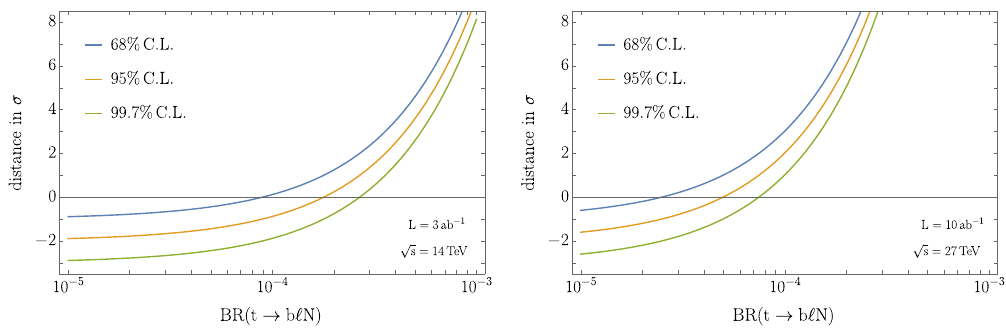
Figure 3 . Number of standard deviations between the mean value of the BDT asymmetry in the signal + background and the asymmetry in the SM alone as a function of the exotic top p decay mode branching ratio for s = 14 TeV and L = 3 ab (cid:0) 1 (left) and for L = 10 ab (cid:0) 1